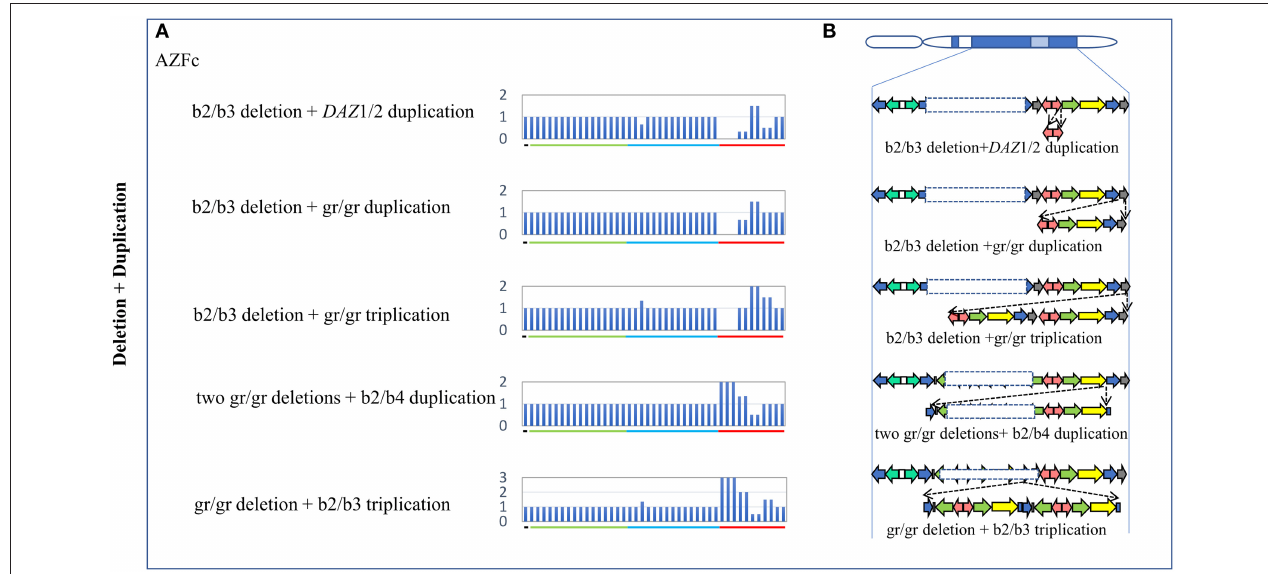
FIGURE 3 | Complex CNVs (Deletion + Duplication) in AZF regions of the human Y chromosome identified by MLPA. (A) Results of MLPA analysis. The relative peak area of each probe was calculated by dividing the actual peak area of the subject by the average of that of five reference samples. Decreased and increased relative peak areas mean copy-number deletions and duplications, respectively. (B) Corresponding structures and rearrangements of AZF regions.